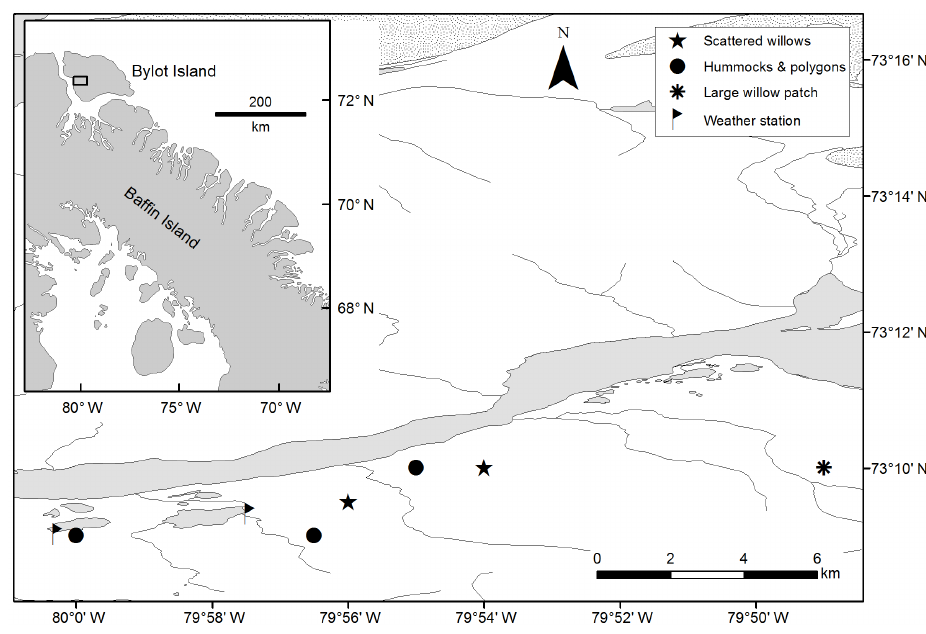
Figure 1. Map showing the location of our study sites in Qarlikturvik Valley, in the south-west plain of Bylot Island, in the Canadian Arctic